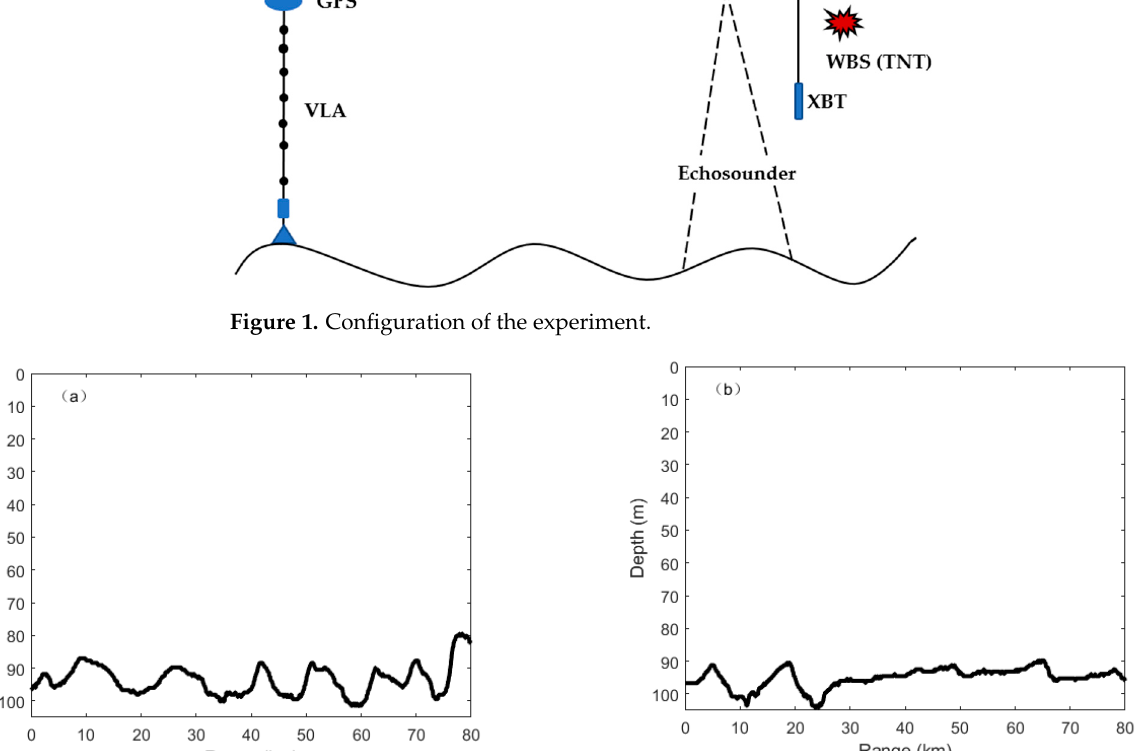
Figure 2. Bathymetry along two propagation tracks, T1O ( a ) and T3O ( b ).